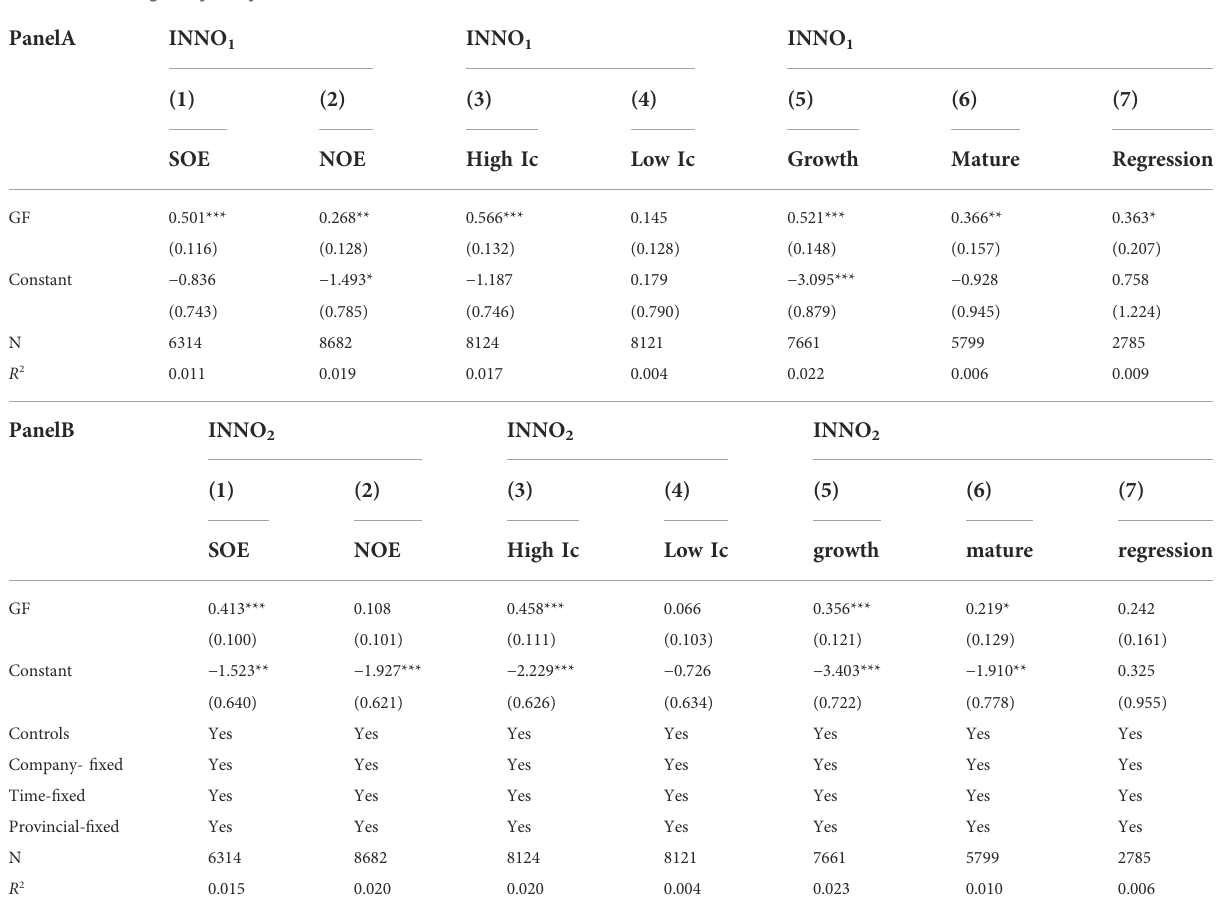
TABLE 10 Heterogeneity analysis results.